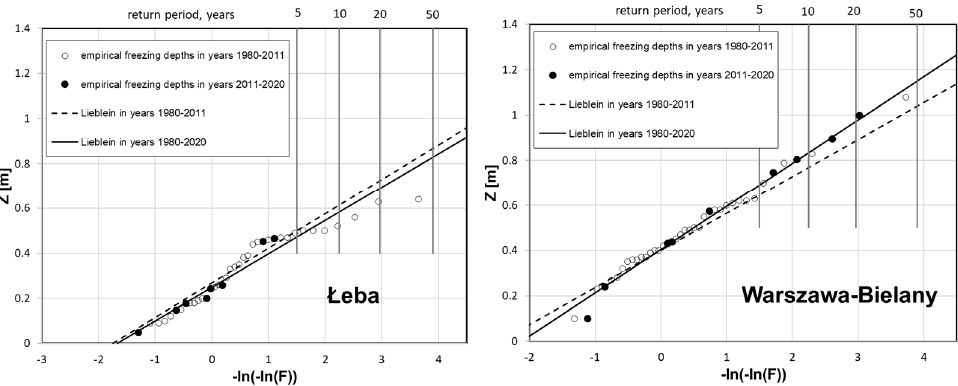
Figure 9. Comparison of predicted and measurement value for chosen location: K ę trzyn ( left ) and K ł odzko ( right ) station .